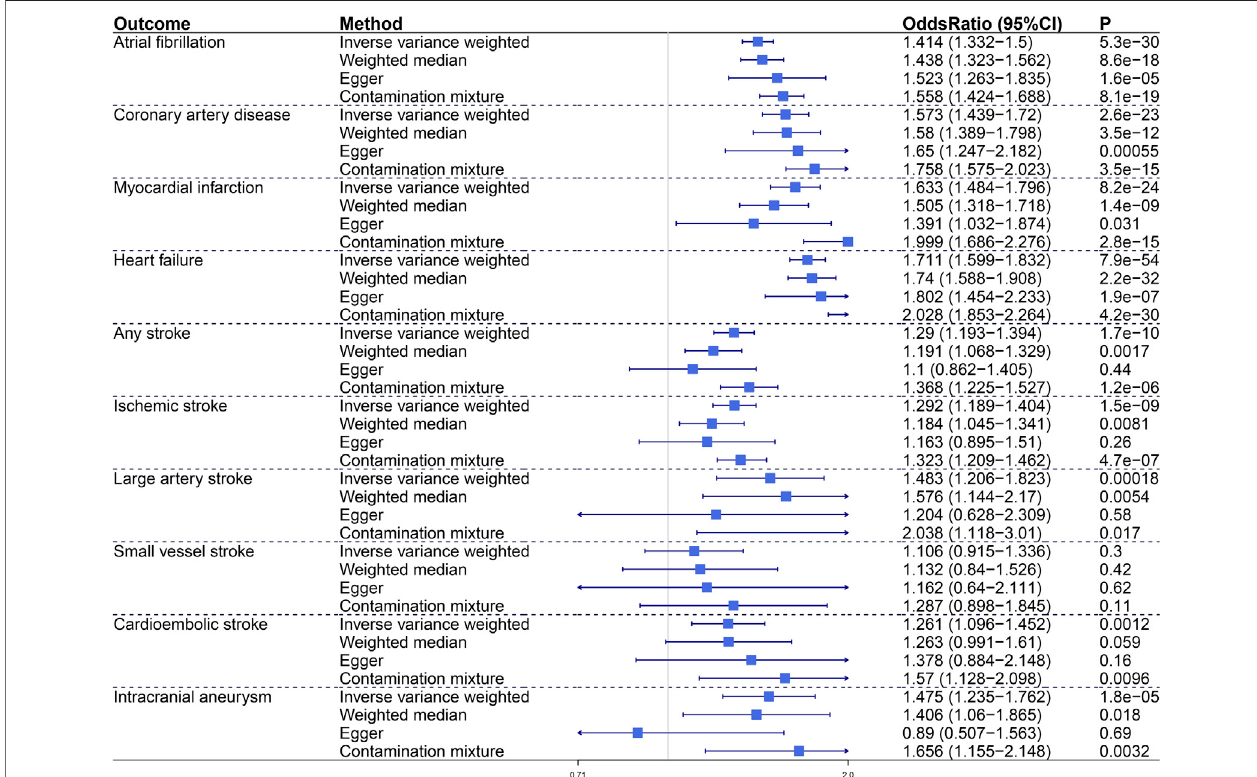
FIGURE 2 | The causal effect of visceral adiposity on 10 independent CVD endpoints. Odds ratios are expressed per 1-SD increase in genetically determined VAT mass. CI, con fi dence interval.